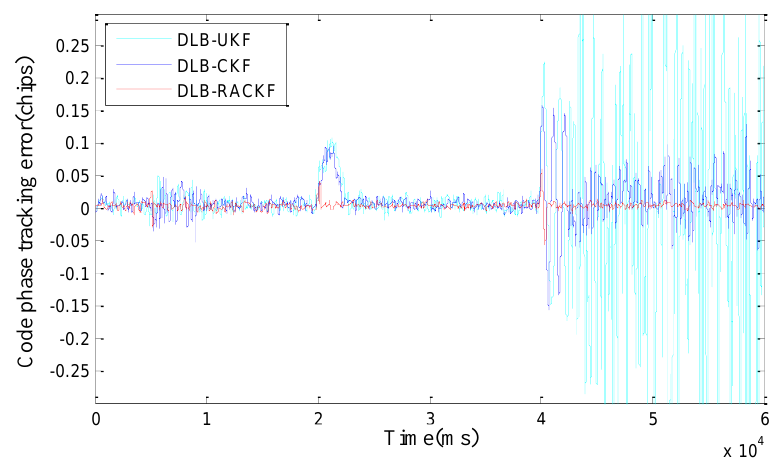
Figure 3. Comparison of the Doppler frequency tracking error among DLB-UKF, DLB-CKF, and DLB- RACKF.